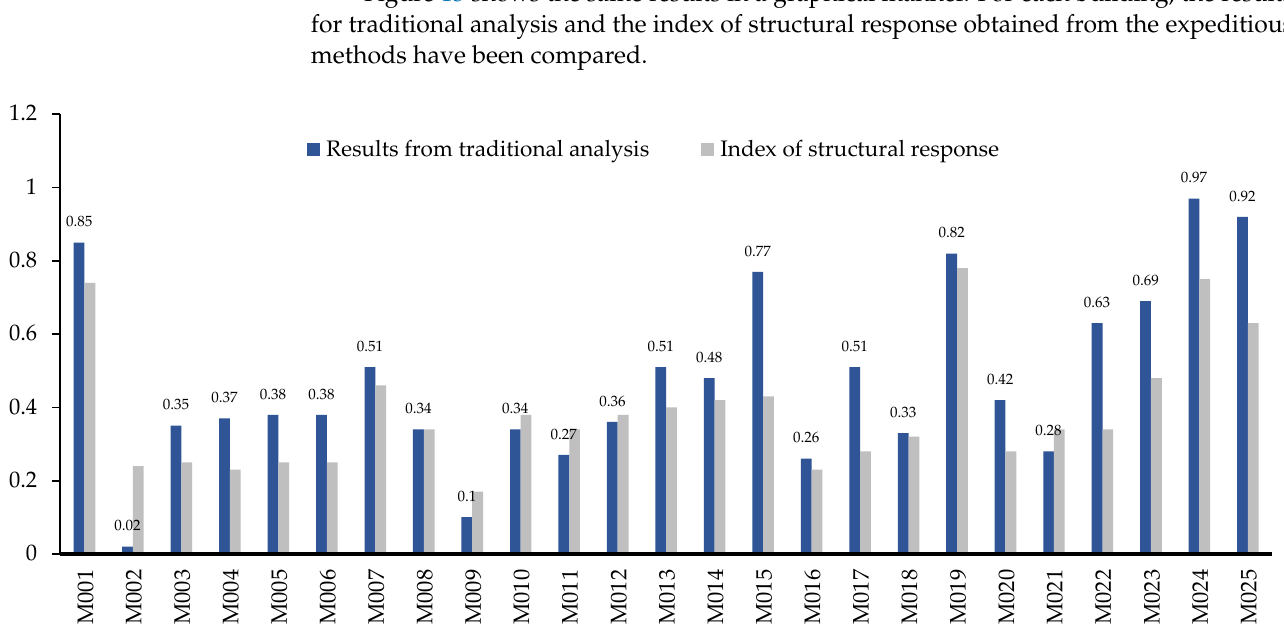
Figure 13. Results of the validation—traditional vs. expeditious methods.